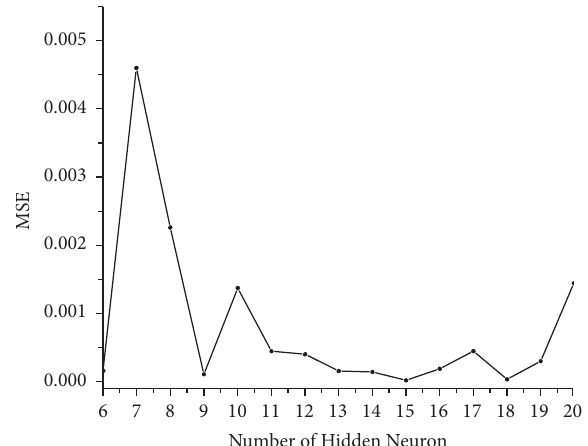
Figure 4: ANN performance evaluation based on the number of hidden neurons for microwave drying of Stevia